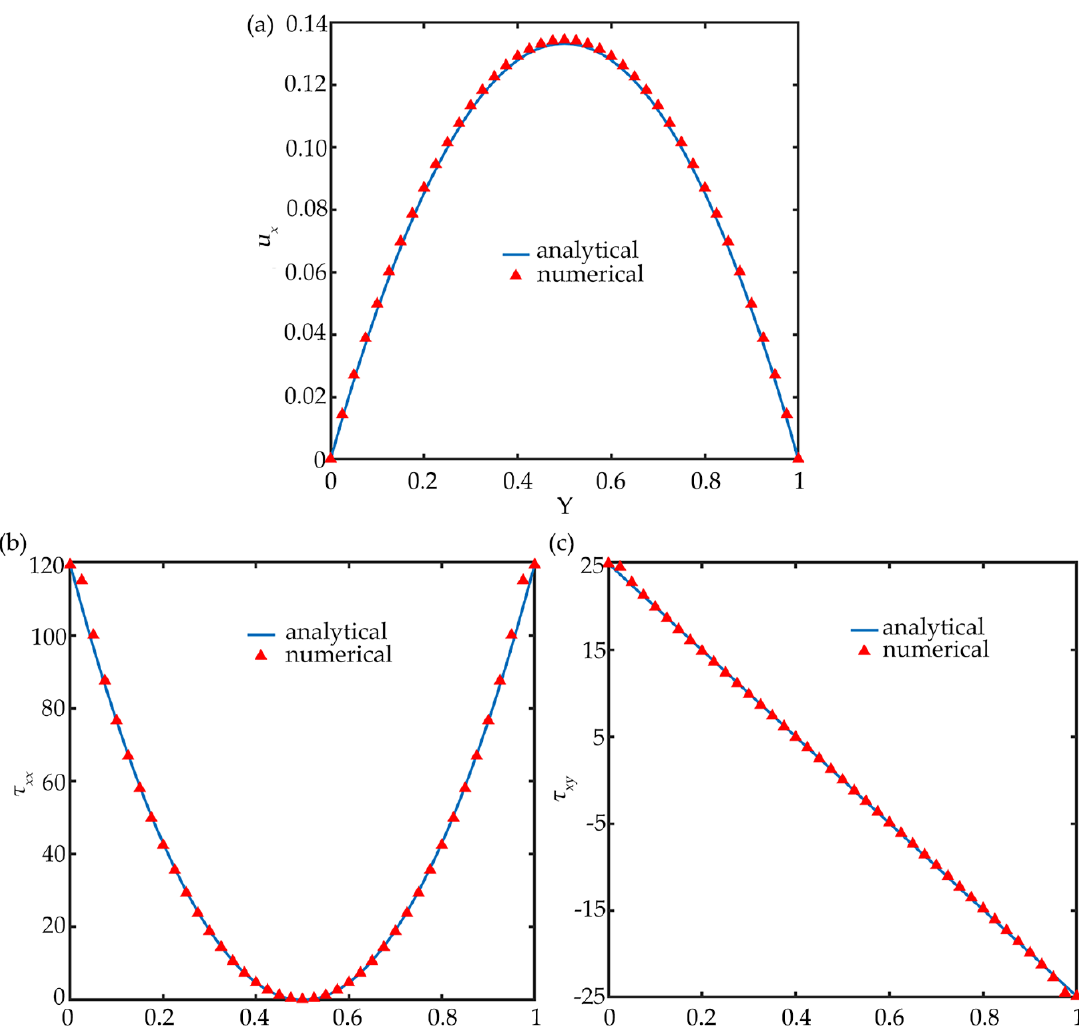
Figure 2. Numerical and analytical results of the velocity distribution ( a ), the normal-stress components τ xx ( b ), and the extra-stress components τ xy ( c ) at the channel center plane under Wi = 0.3, Re = 1.0, and β = 0.3.